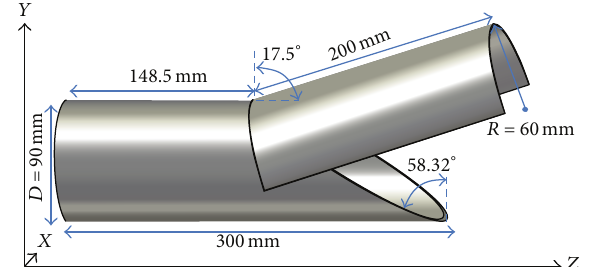
Figure 8: Bevel-cut Vlasov antenna with